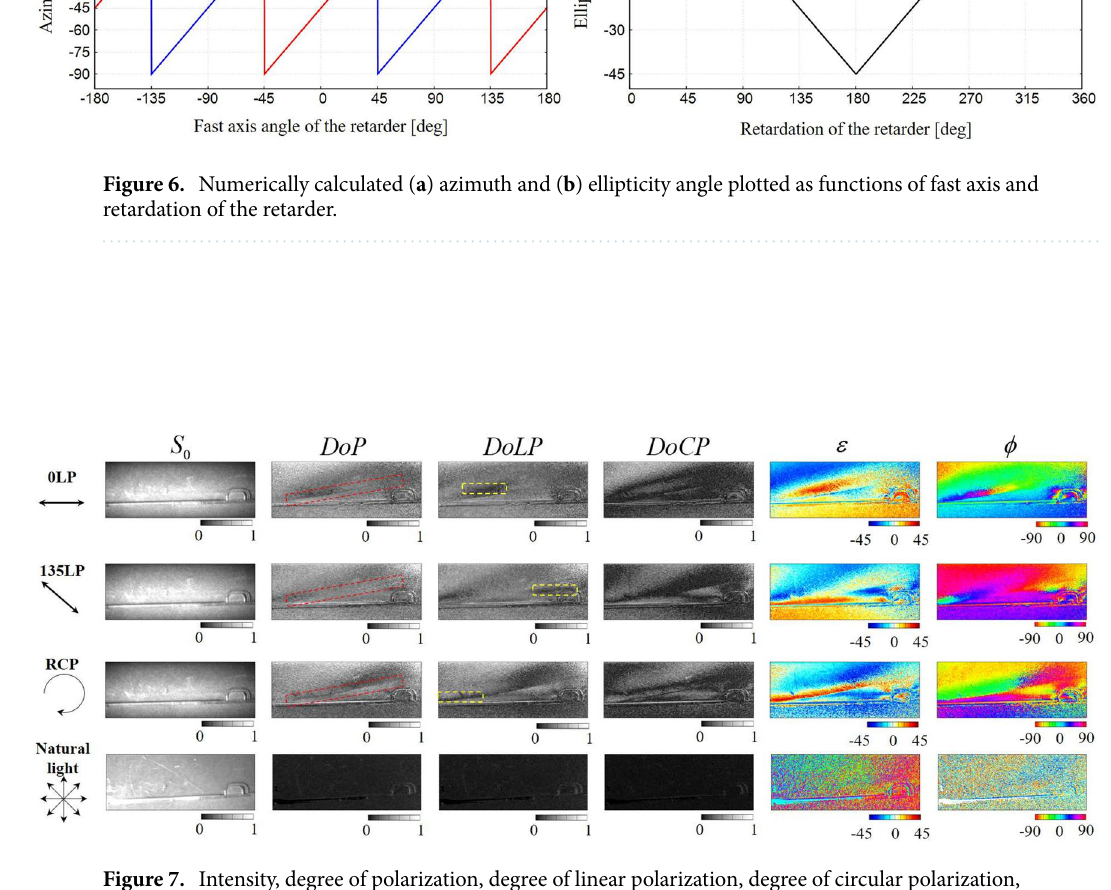
Figure 7. Intensity, degree of polarization, degree of linear polarization, degree of circular polarization, ellipticity angle, and azimuth angle calculated from the Stokes parameters of the CD case obtained using the PPPI